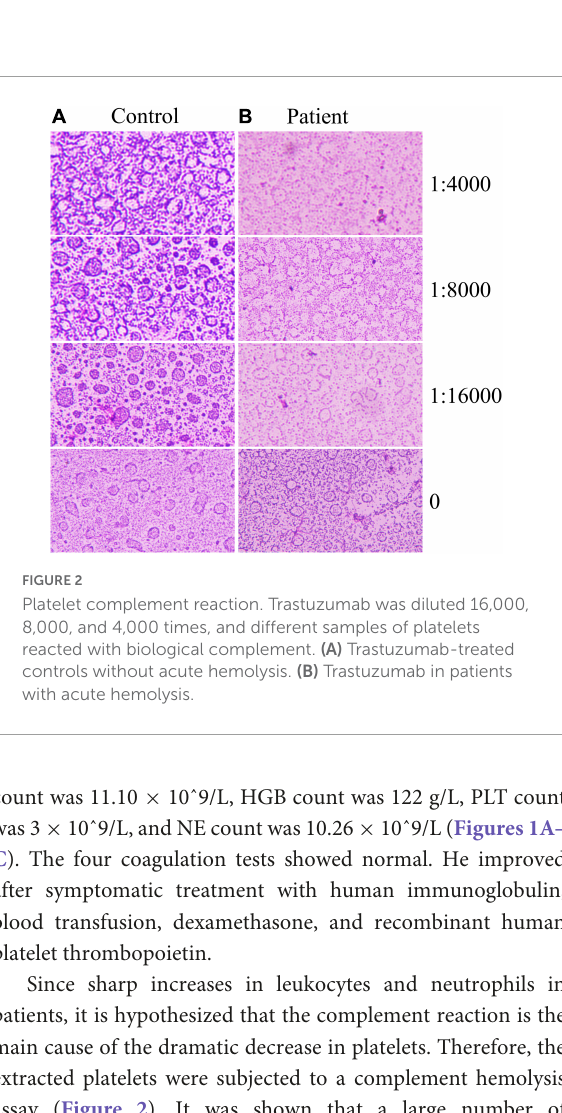
count was 11.10 × 10ˆ9/L, HGB count was 122 g/L, PLT count was 3 × 10ˆ9/L, and NE count was 10.26 × 10ˆ9/L ( Figures